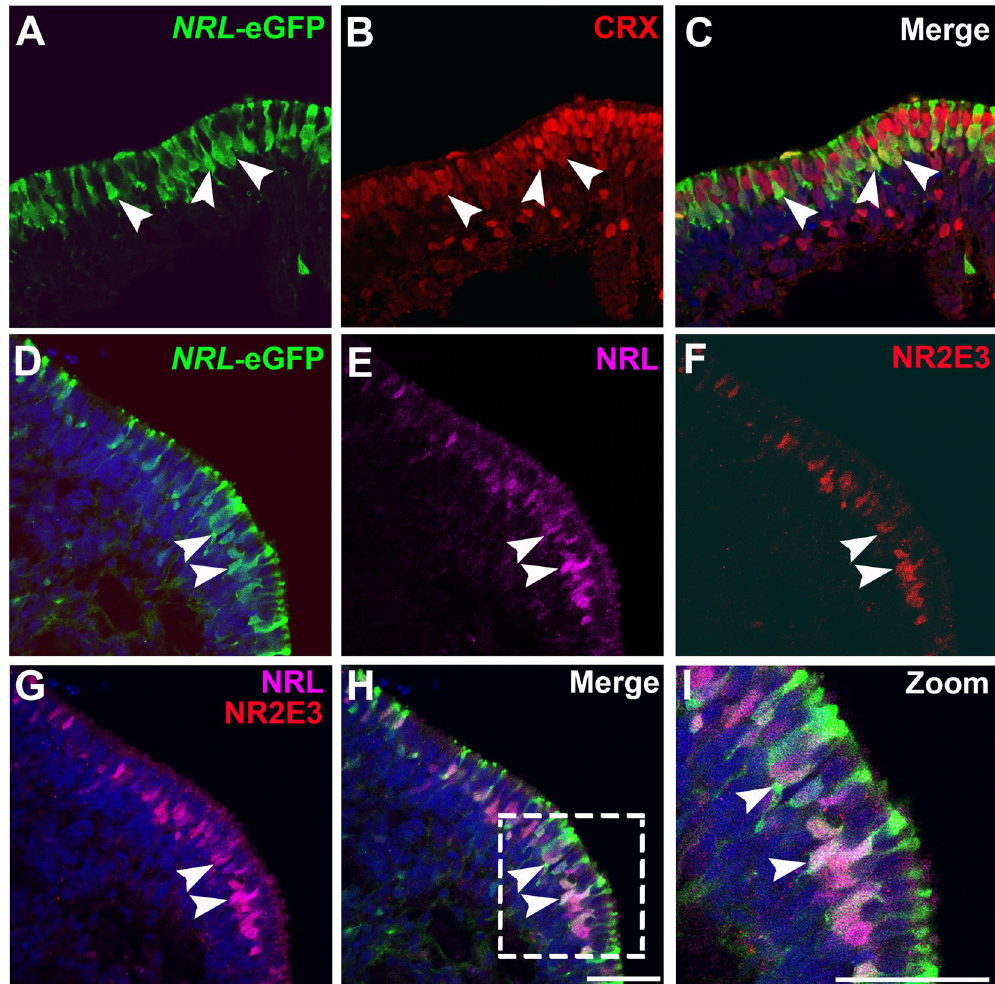
Figure 4. eGFP expression and specificity during early rod production in NRL + /eGFP OVs. To examine early rod production in NRL + /eGFP OVs, OVs at d90 of differentiation were analyzed by immunocytochemistry. ( A–C ). All NRL -eGFP + cells co-expressed CRX (arrowheads), but not all CRX + cells expressed eGFP. ( D–I ) NRL -eGFP ( D ) co-labeled with NRL ( E ) and NR2E3 ( F ), demonstrating specific expression of eGFP in rod photoreceptors (merged images in ( G – I ). Examples of co-localization of NRL and NR2E3 with eGFP highlighted by arrowheads in panels D–I. Scale bars = 50 µ